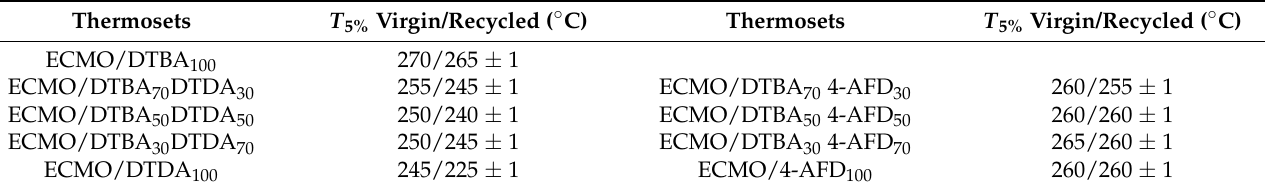
Table 3. T 5% for virgin and recycled thermosets .